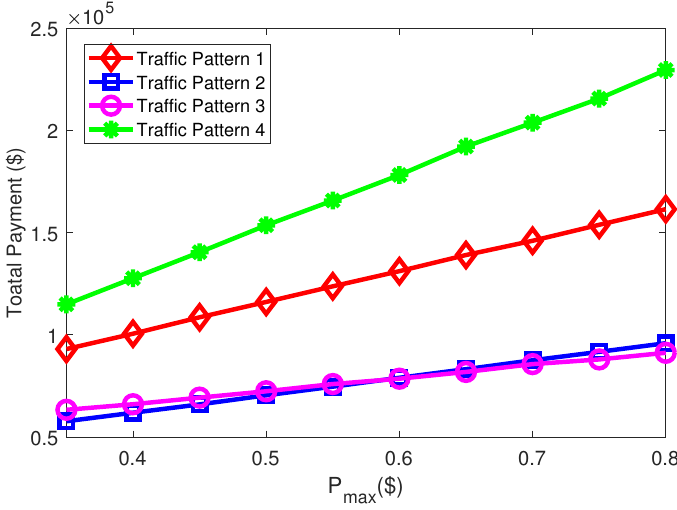
Figure 18. Impact of P max on total payment in PARM.